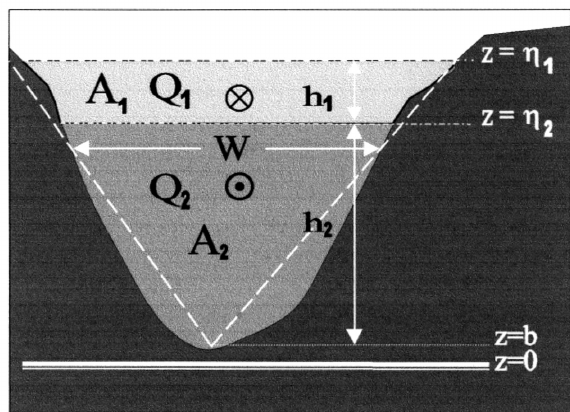
F IG . 2. – Sketch of the cross-area (dark shadow) and the equivalent triangular section (white dashed line) of the Strait of Gibraltar. Letters indicate the parameters and variables used in the